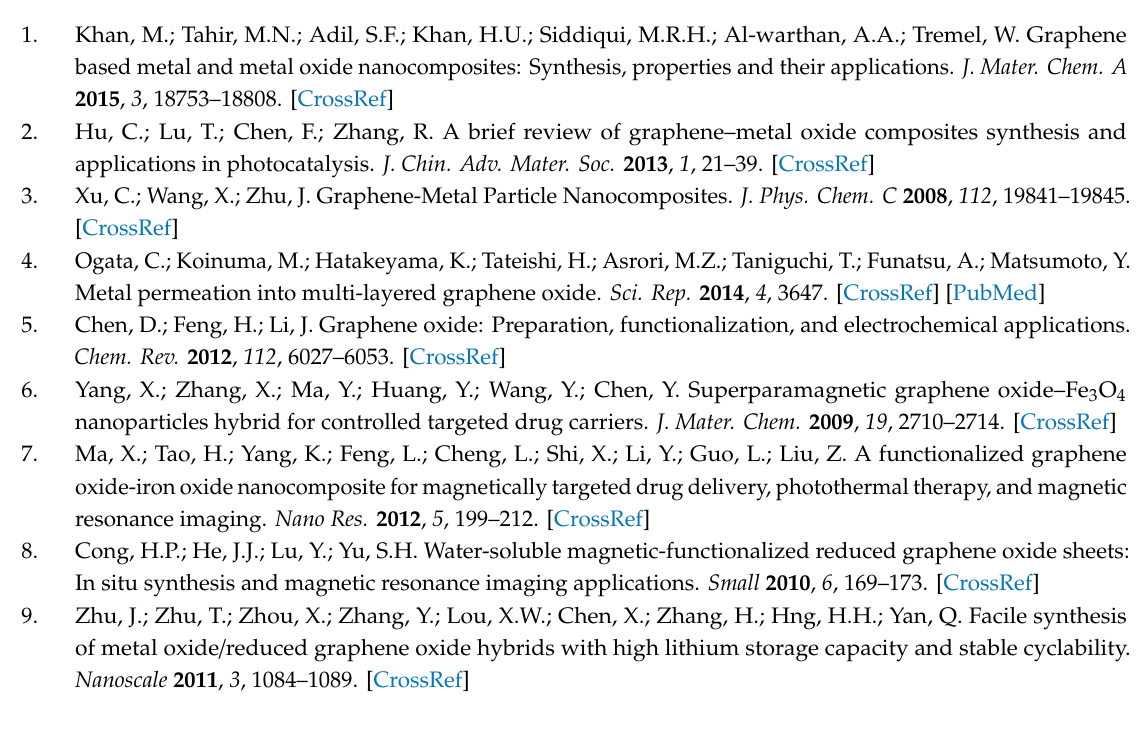
Figure S1: EDS spectra of GO-Sn (up) and GO-Fe (bottom) composites, Figure S2: XPS spectra (Survey) of (a) GO-Sn, (b) GO-Fe, (c) GO-Zn, (d) GO-Al, (e) GO-Mg and (f) GO materials, Figure S3: XPS spectra of (a) GO-Fe, (b) GO-Zn, (c) GO-Al and (d) GO-Mg composites, Figure S4: XPS spectrum and deconvolution of GO-Sn composite, Figure S5: Raman spectrum of (a) GO-Sn, (b) GO-Fe, (c) GO-Zn, (d) GO-Al (e) GO-Mg and (f)